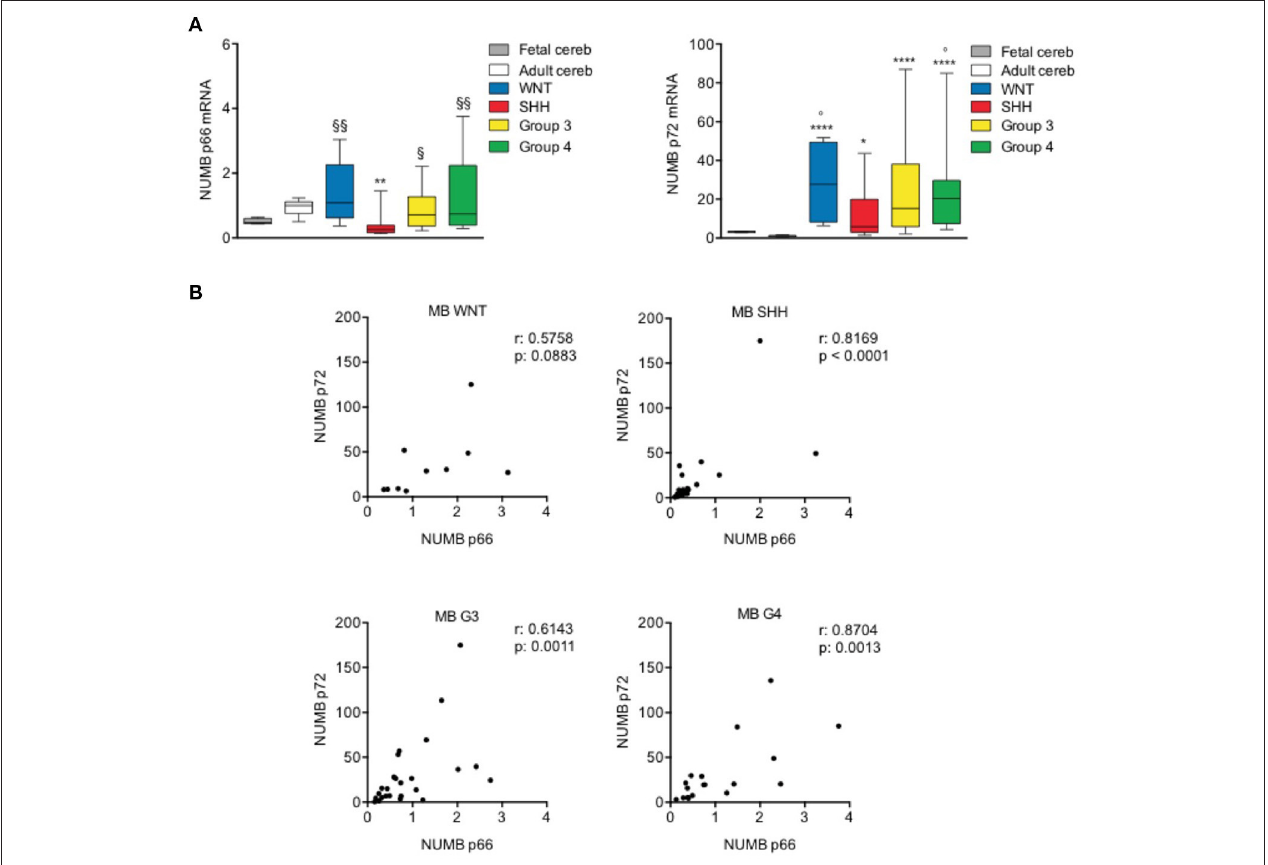
FIGURE 4 | NUMB isoforms expression in human MB samples. (A) qRT-PCR analysis showed NUMB isoforms [p66 (left) and p72 (right)] mRNA expression for molecular subgroups of primary MBs (WNT n : 10; SHH n : 25; G3 n : 25; G4 n : 19), adult normal cerebellum (Adult cereb) and fetal normal cerebellum (Fetal cereb). * P -value vs. Adult cereb, * p < 0.05; ** p < 0.01; **** p < 0.0001. ◦ = P vs. Fetal cereb, ◦ p < 0.05. § P -value vs. SHH MBs, § p < 0.05; §§ p < 0.01. (B) Pearson’s correlation test of p66 vs. p72, in human MB subgroups, to evaluate the link between the expression of NUMB isoforms (r = correlation coefficient; p < 0.05